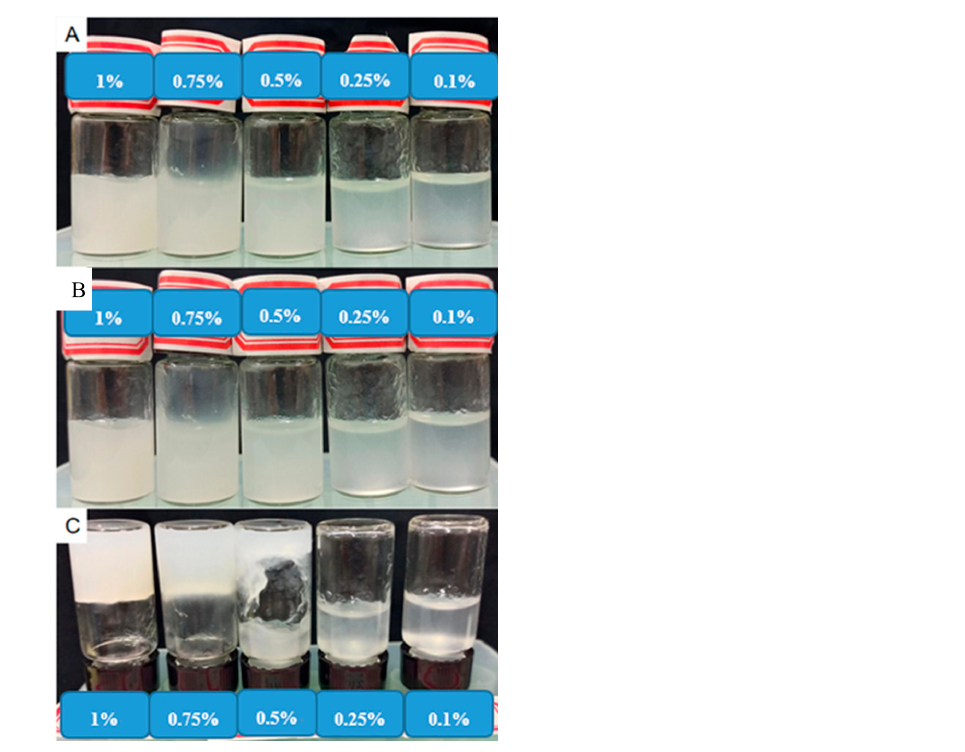
Figure 4. CNF suspensions at different concentrations (( A ) Day 1; ( B ) Day 30; ( C ) Inverted after 30 days).